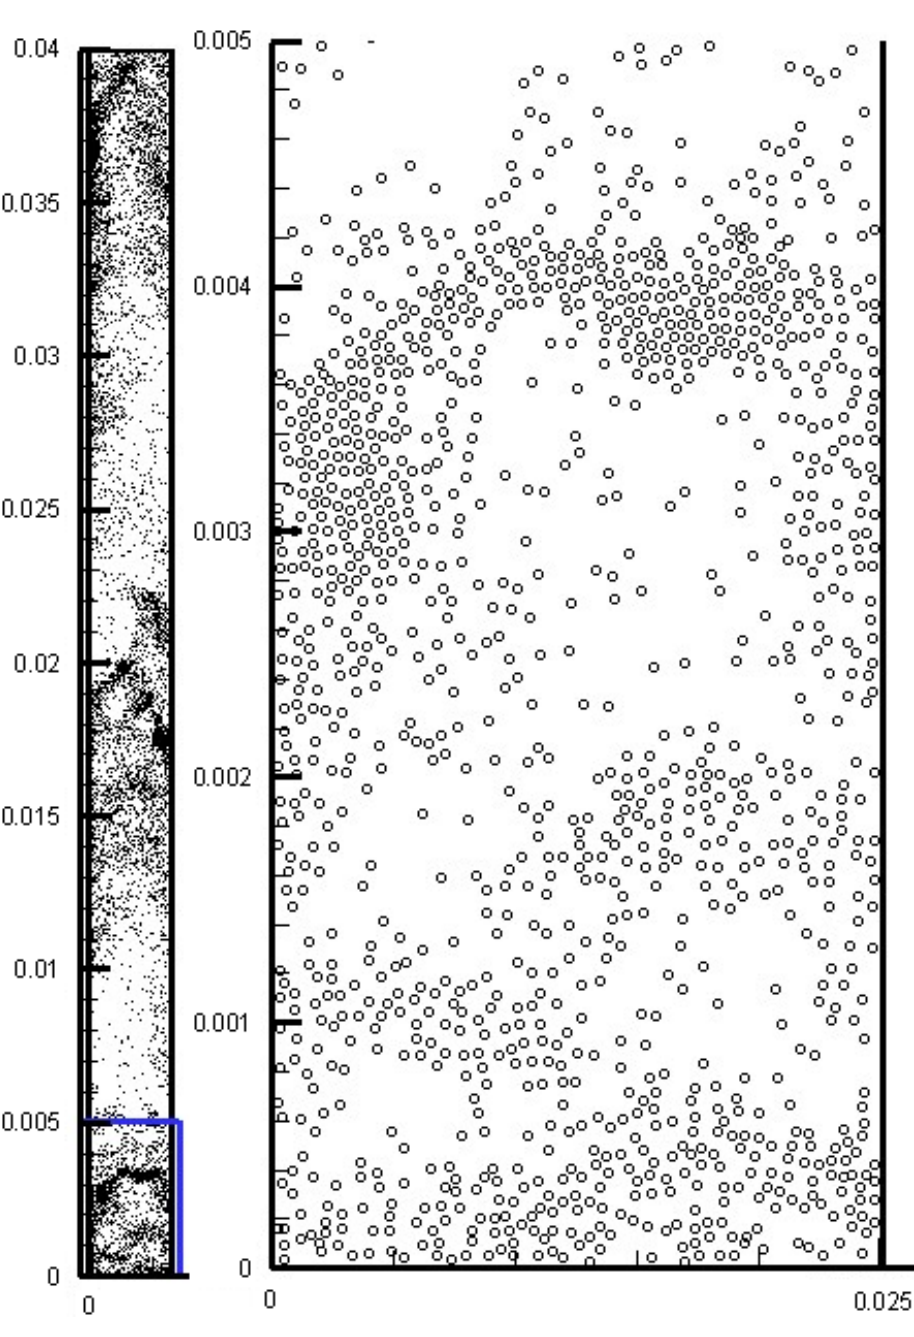
Figure 2. Particle locations at 0.123 s, with large t r = 31.0